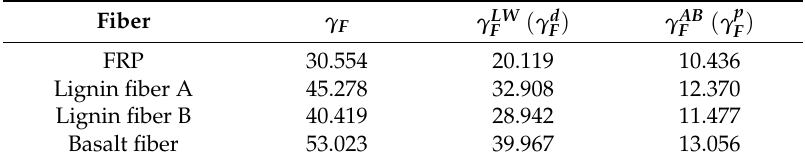
Table 5. Surface energy of the fibers (MJ/m 2 ).